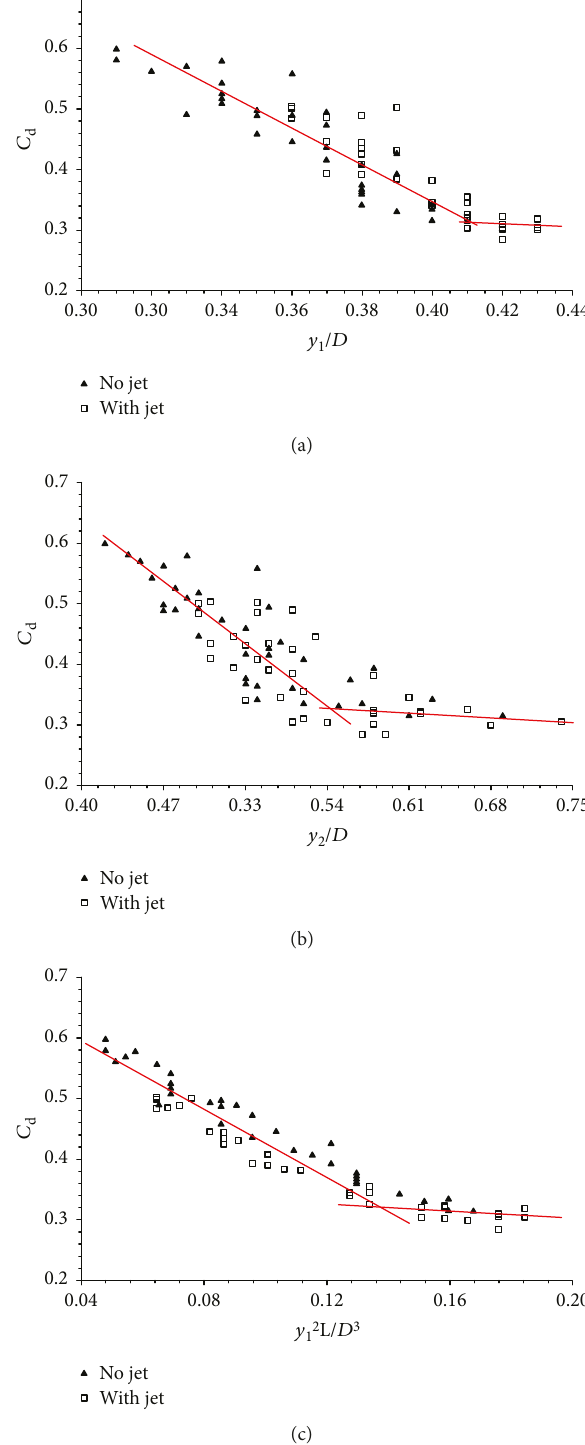
/ D ; (c) Vary with 2